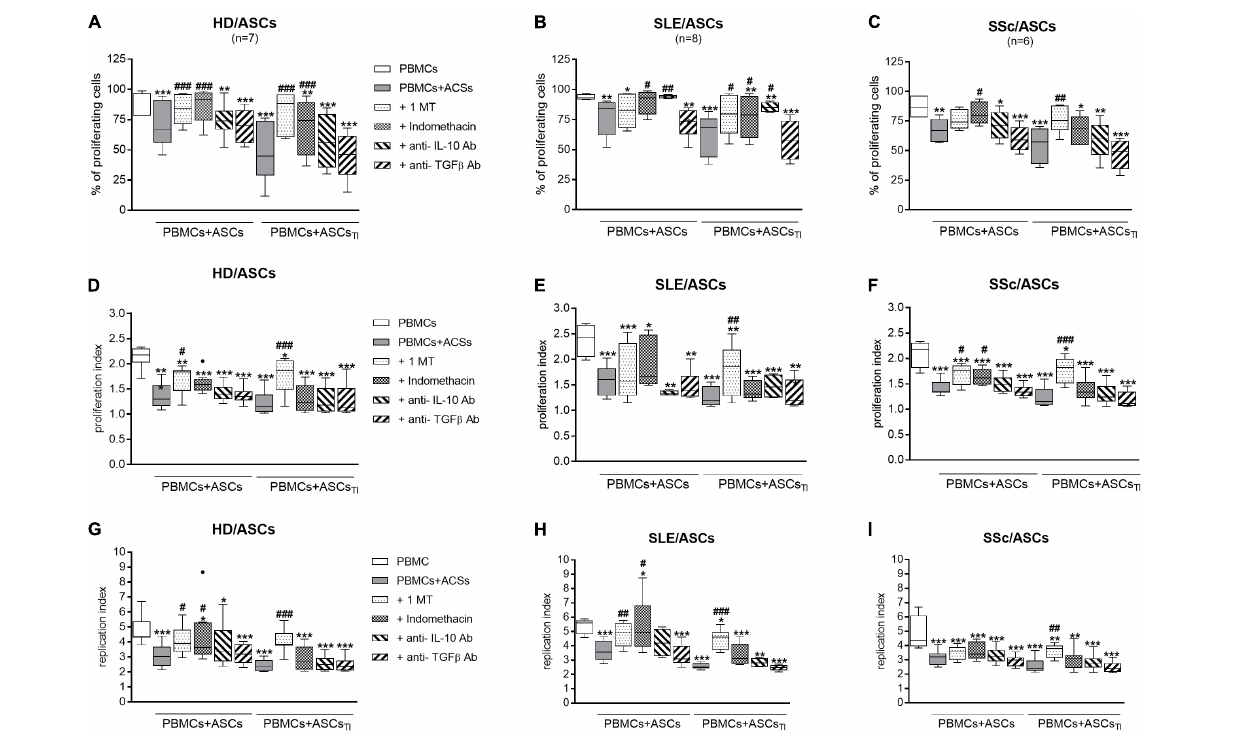
FIGURE 8 | Selective inhibitors of kynurenines (1-MT) and PGE 2 (indomethacin) synthesis counteract anti-proliferative impact of ASCs on CD4 + T-cells, while cytokine neutralization has negligible effect. Cell preparation and culture conditions as in Figure 1 . Proliferation of CD4 + T-cells from PBMCs co-cultured with ASCs obtained from HD (A,D,G) , SLE (B,E,H) SSc (C,F,I) patients. The concentrations and time of cell treatment with 1-MT, indomethacin, and cytokine specific neutralizing antibodies are described in Materials and Methods. Data, shown as the Tukey’s boxes, are the results of indicated number of experiments (n) in which PBMCs obtained from 7 healthy blood volunteers were co-cultured with 3 HD/ASCs, 4 SLE/ASCs, and 5 SSc/ASCs. * P < 0.05, ** P < 0.01, *** P < 0.001 for comparisons of cell co-cultures vs separate control cultures; # P < 0.05, ## P < 0.01, ### P < 0.001 for comparison of inhibitor treated vs. untreated co-cultures. Other explanations as in Figure 1